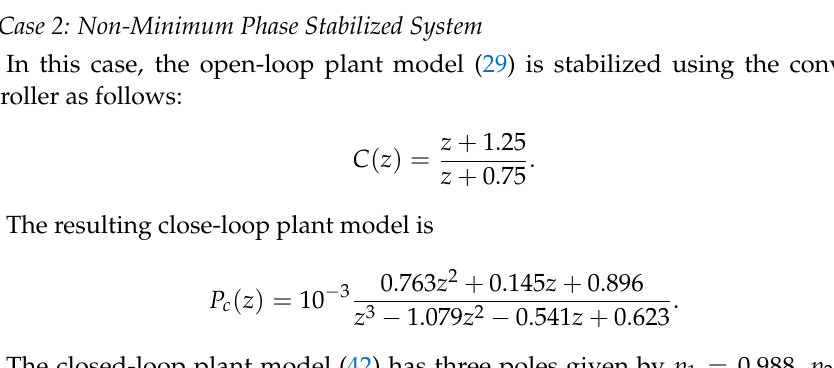
Figure 10. Magnitude responses of the simulated DIMRC and